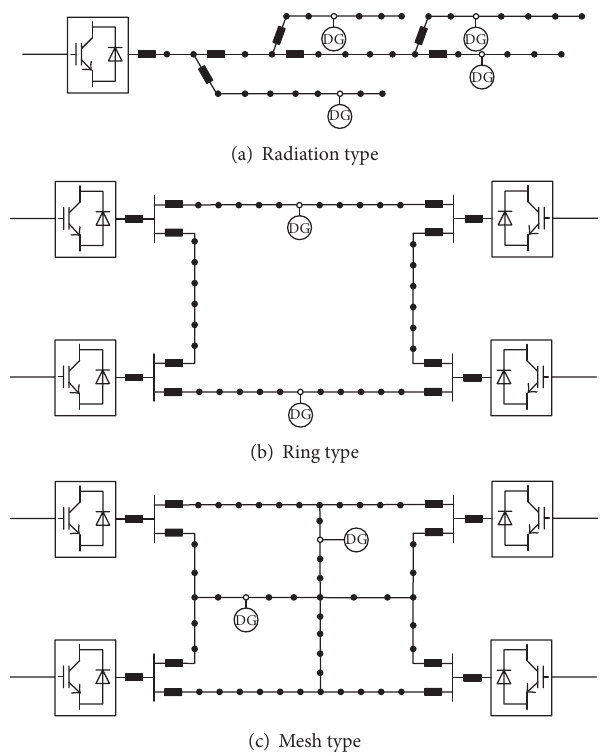
Figure 1: The diagram of three kinds of the basic topologies of DC distribution